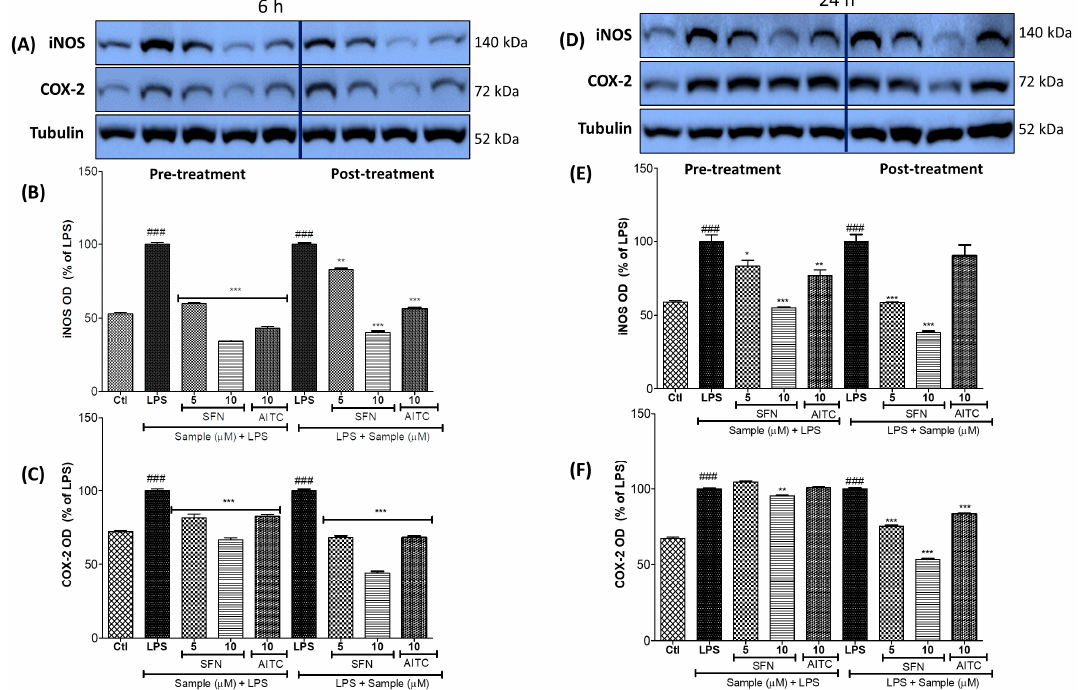
Figure 3. SFN inhibited the expression of iNOS and COX-2 in LPS-activated BV2 microglial cells. The cells were pre-/post-treated with SFN or AITC. LPS (100 ng/mL) activation was performed for 6 or 24 h and the expression of the proteins was evaluated by western blot analysis. ( A – C ) Quantification of iNOS and COX-2 expression after 6 h of LPS activation. ( D – F ) Quantification of iNOS and COX-2 expression after 24 h of LPS activation. α -Tubulin was used as a loading control. All data are presented as the mean ± standard error of the mean of three independent experiments. * p < 0.05, ** p < 0.01, and *** p < 0.001 indicate significant differences compared with LPS treatment alone; ### p < 0.001 indicates significant differences compared with the untreated control group. Ctl— untreated control cells; LPS—cells treated with lipopolysaccharide only.